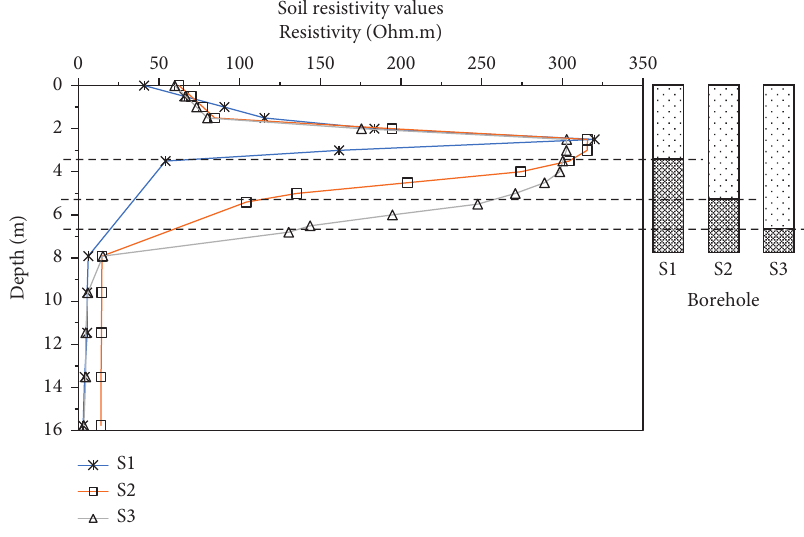
Figure 8: Soil resistivity values at Klias.